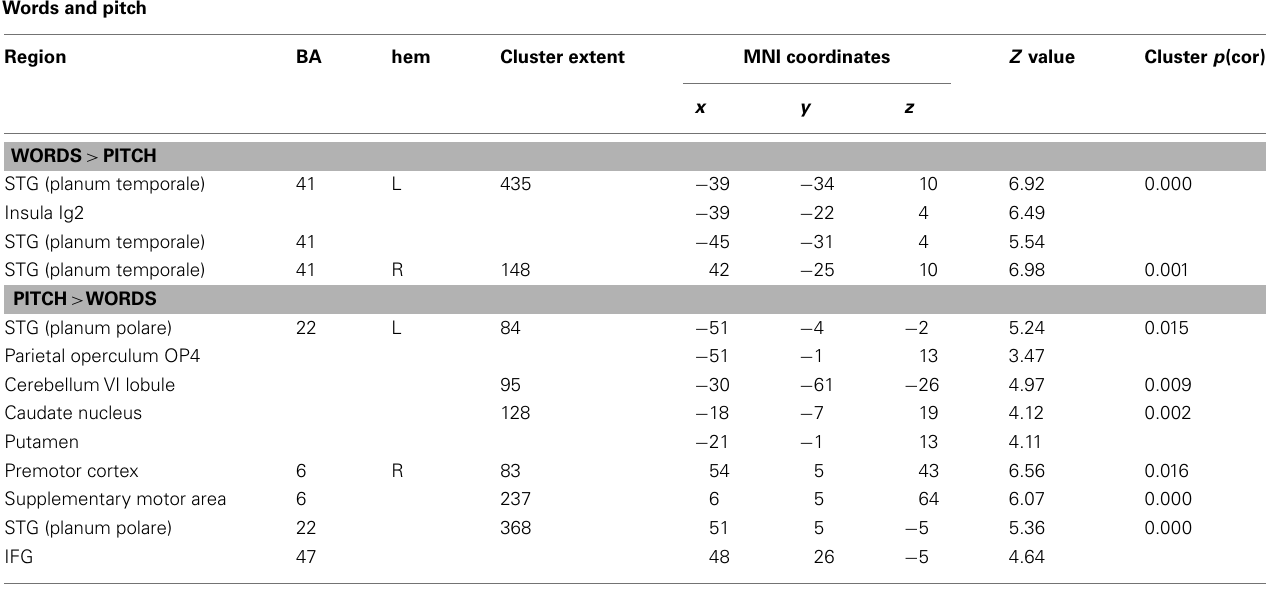
FIGURE 3 | Brain regions that distinguish between pitch–rhythm patterns and rhythm in song and speech [second vs. third level: SPKpr vs. SPKr and SNGpr vs. SNGr; p (cluster-size corrected) < 0.05 in combination with p (uncorrected) < 0.001]. Bargraphs depict beta values Table 3 | Brain areas involved in the processing of words and pitch in vocal